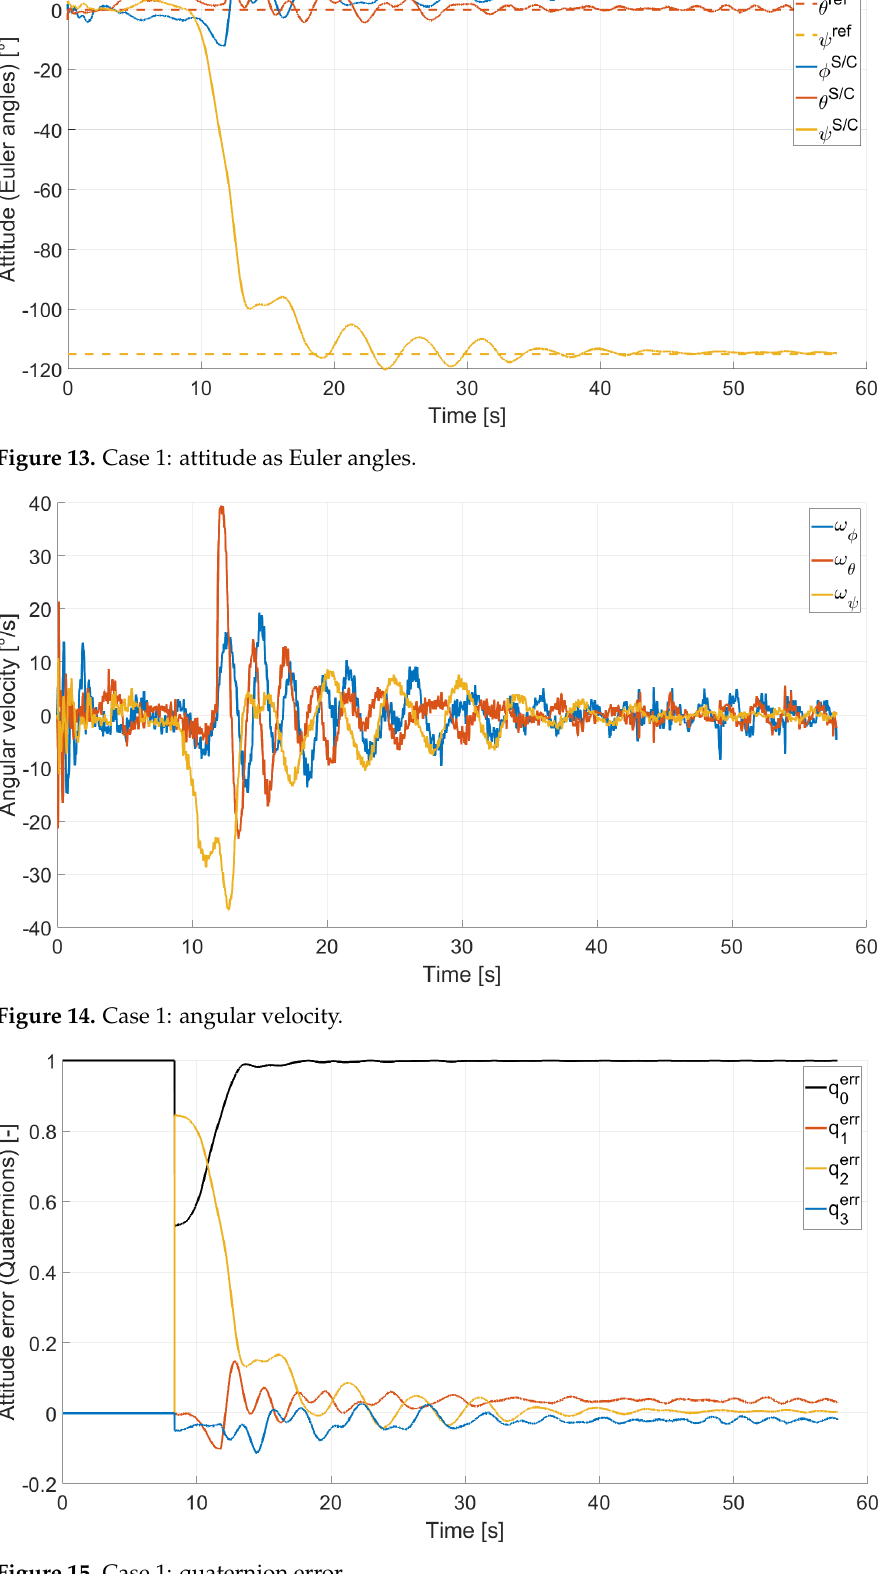
Figure 15. Case 1: quaternion